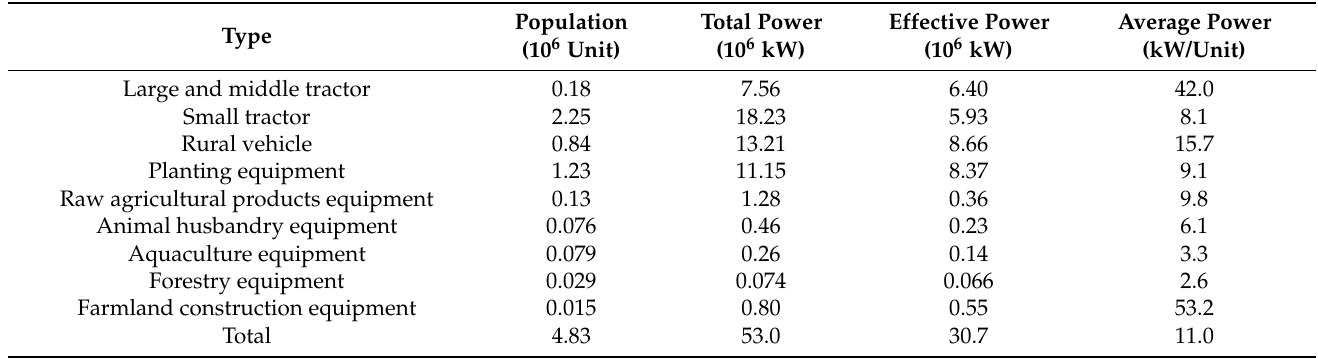
Table 1. Population and power of diesel agricultural machinery (AM) in Anhui in 2013 [23].